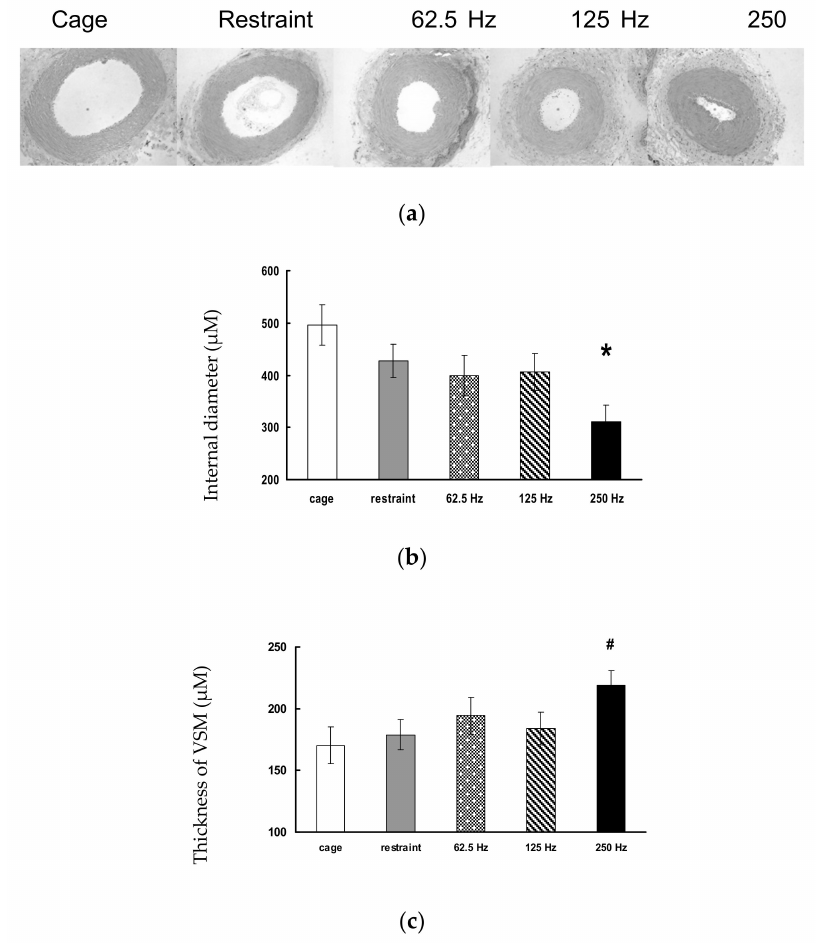
Figure 15. ( a ) The photomicrographs show hematoxylin and eosin staining in the ventral tail arteryafter exposure to vibration at various frequencies; ( b ) Exposuer at 250 Hz resulted in a signifi- cant reduction in the internal diameter of the ventral tail artery (* different than all other conditions, p < 0.05); and ( c ) An increase in the smooth muscle thickness in the ventral tail artery (# different than cage control, p <